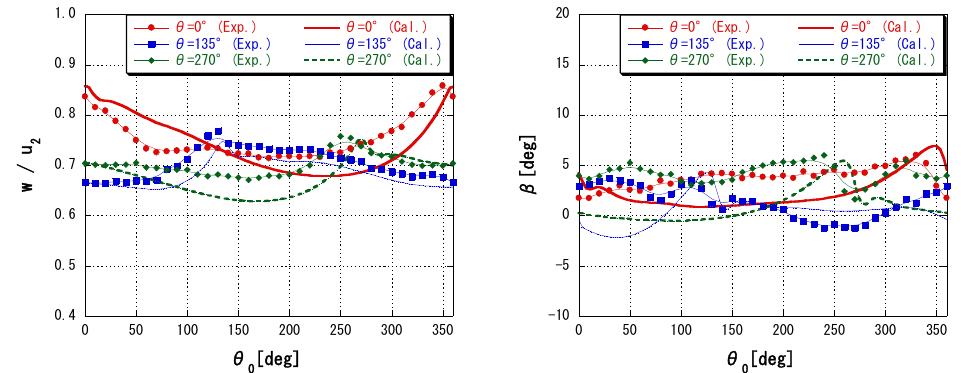
Fig. 15 w distributions ( φ =0.025 ， b / b 2 =0.5) Fig. 16 β distributions ( φ =0.025 ， b / b 2 =0.5)